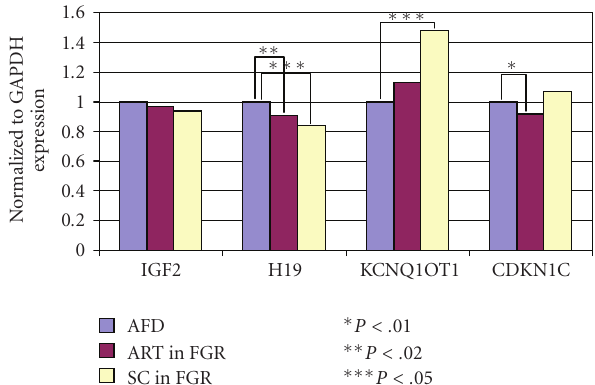
Figure 2: Gene expression of placental tissue. ART versus SC in FGR cases. There were no di ff erences in the gene expression of IGF2; however, H19 expression was significantly reduced in FGR cases both in the ART and SC groups compared with the AFD birth weight cases ( P < .02 and P < .05, resp.). Conversely, KCNQ1OT1 was hyperexpressed in FGR cases in the SC group ( P < .05), while CDKN1C expression was reduced in FGR cases in the ART group ( P <